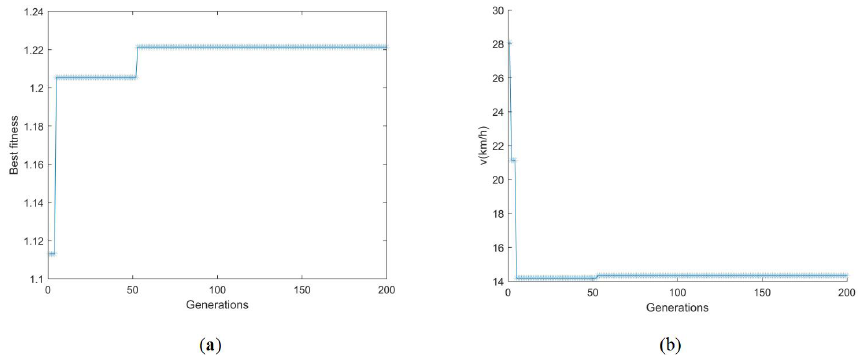
Figure 5. The iterative process of each variable of the passive suspension vehicle. (a) All individuals’ optimal fitness. (b) Optimal individ- ual’s v.